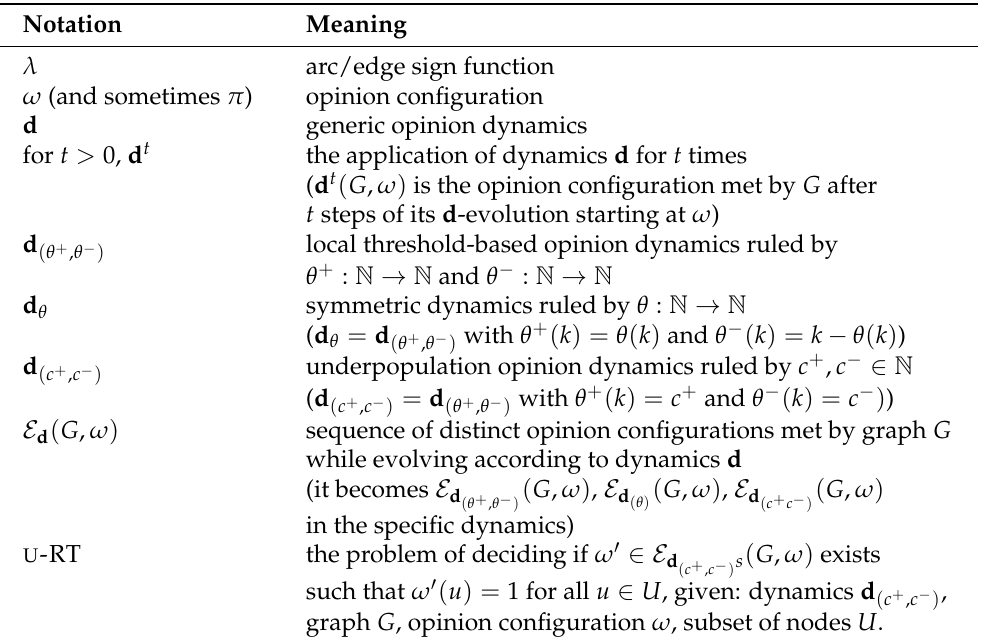
Table 1. List of